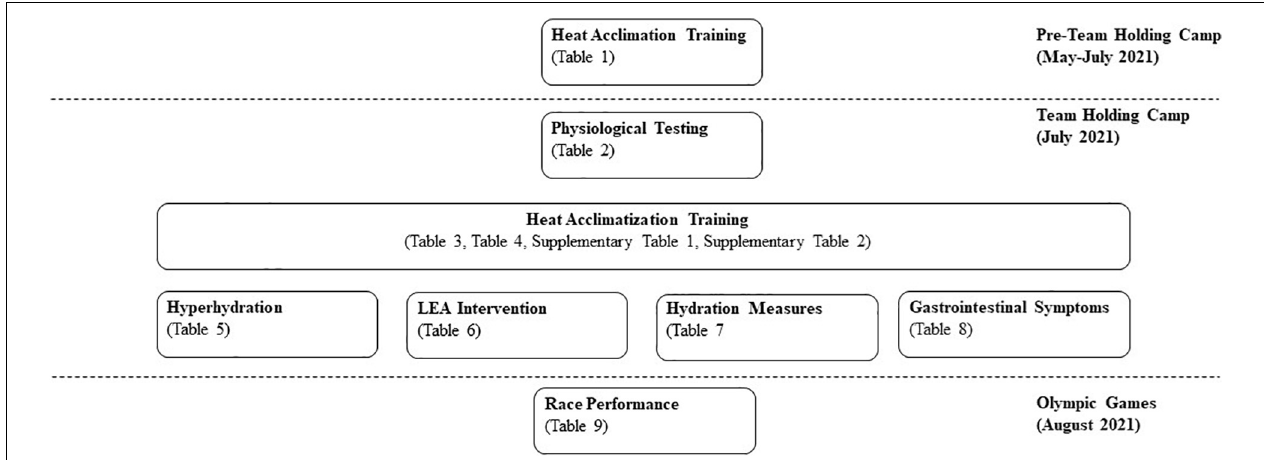
FIGURE 1 | Schematic of activities for Australian race walkers ( n = 6) prior to and during the team holding camp, and during the Tokyo Olympic Games. LEA; low energy availability.